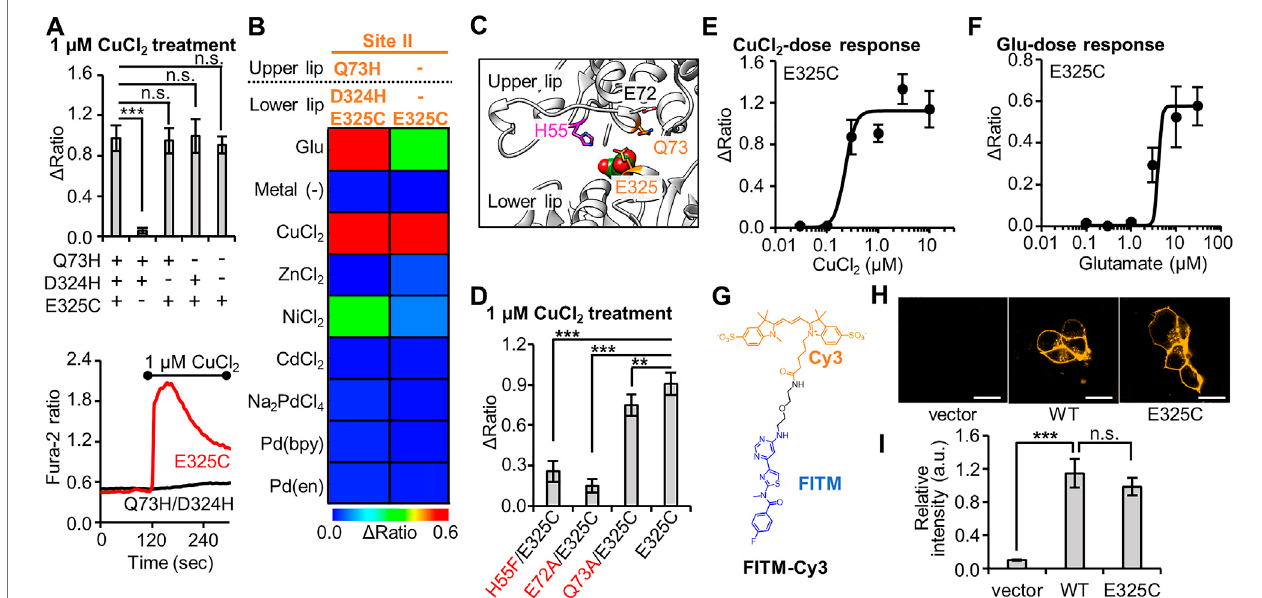
FIGURE2| OptimizationofCu 2+ -responsivemGlu1mutantanditscharacterization. (A) Mutationstudytocon fi rmtheimportanceofHis-andCys-incorporationat the mutation sites. Upper ; the average Δ ratio values for Q73H/D324H/E325C, Q73H/D324H, Q73H/E325C, D324H/E325C, or E325C mutant upon the treatment of 1 μ MCuCl 2 .(n (cid:1) 12 – 20). Lower ;representativetraces fromE325CorQ73H/D324H mutant. Theblackbar represents theperiodwhenCuCl 2 wasadded. (B) Heatmap showing the metal selectivity of the newly identi fi ed Cu 2+ -responsive E325C mutant. The map shows the average Δ ratio values upon the addition of 10 μ M glutamate or 3 μ M metal ion or complex. See Supplementary Figure S3 for raw data. (C) Candidate residues for the coordination of Cu 2+ with E325C in the VFT domain (PDB ID; 1EWK). (D) Mutation study to identify the coordination residues. The average Δ ratio values upon the treatment of 1 μ M CuCl 2 are shown. (n (cid:1) 12 – 20). (E) Activation of the mGlu1 E325C mutant by Cu 2+ . The EC 50 value for mGlu1 E325C mutant was 0.22 μ M. (n (cid:1) 12 – 20). (F) Activation of the mGlu1 E325C mutant by glutamate (Glu). The EC 50 value of the mutant was 4.0 μ M. (n (cid:1) 12 – 20). (G) Chemical structure of FITM-Cy3. (H) Evaluation of the expression and distribution of mGlu1 mutant on the cell surface using FITM-Cy3. The representative confocal images are shown. The scale bar shows 20 μ m. (I) Quanti fi cation of signal intensity from FITM- Cy3. (n (cid:1) 20 – 31). Data are presented as mean ± s.e.m. ***Signi fi cant difference ( p < 0.001, One-way ANOVA with Dunnet ’ s test). **Signi fi cant difference ( p < 0.01). n.s, not signi fi cant ( p >